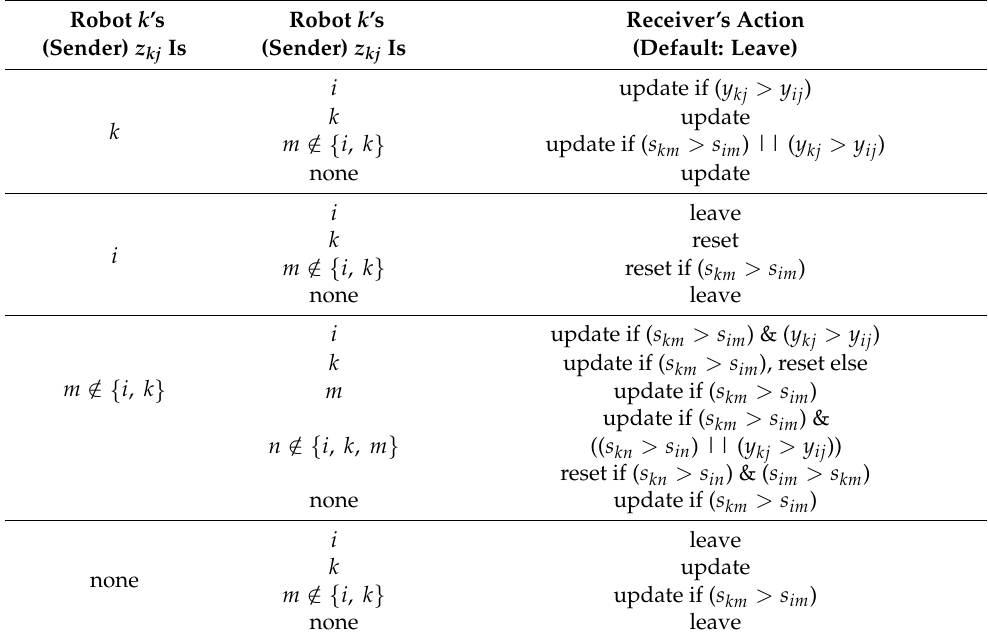
Table 1. Conflict resolution rules for mission j of robot i which communicates with robot k